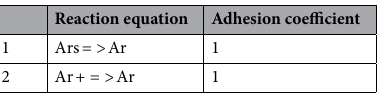
Table 2. Electrochemical reactions on the inner surface of the tube